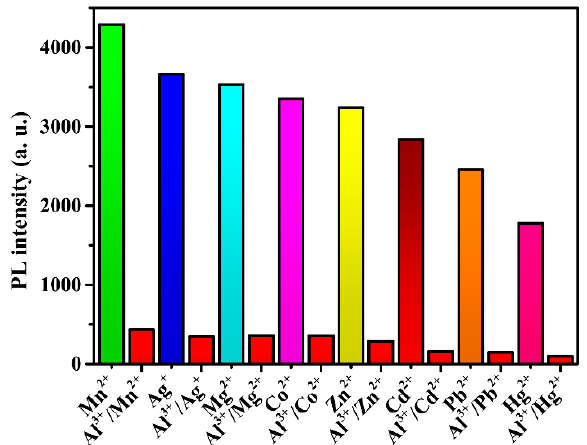
Figure 9. Luminescence intensities of 2 responding to interfering ions in the course of detecting Al 3+ ions.